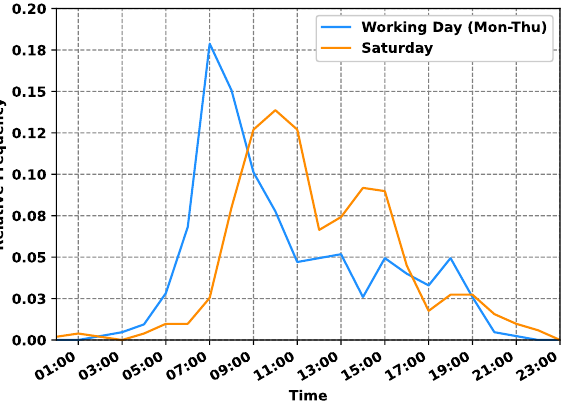
Figure 6. Starting time of the first trip on a working day (Monday–Thursday) and a